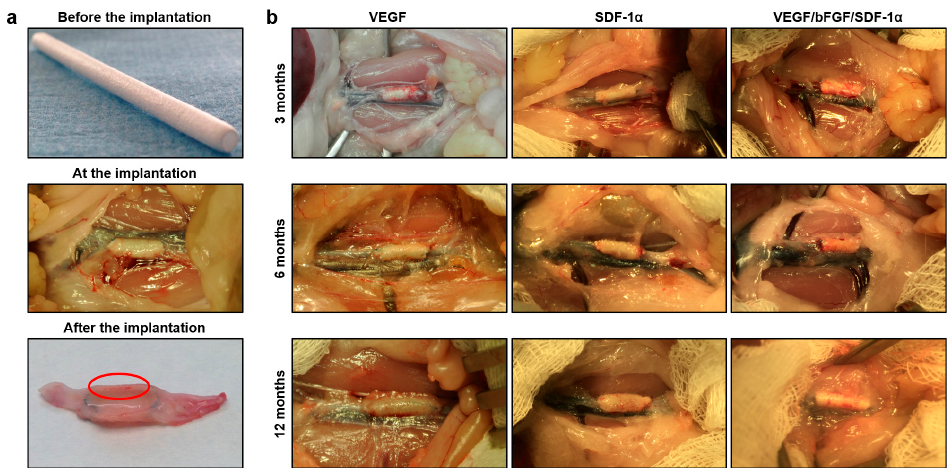
Figure 4. Gross examination of the vascular grafts. ( a ) Electrospun scaffold before the implantation, at the implantation into the rat abdominal aorta and its cross-section after the explantation. Red circle demarcates intramural vasa vasorum; ( b ) One-layer grafts containing exclusively VEGF or SDF-1 α or two-layer grafts with all three bioactive factors (VEGF, bFGF, and SDF-1 α ) implanted into the rat abdominal aorta. Note the integrity of the polymer scaffold and notable vasa vasorum network in VEGF/bFGF/SDF-1 α -containing grafts at all the time points.